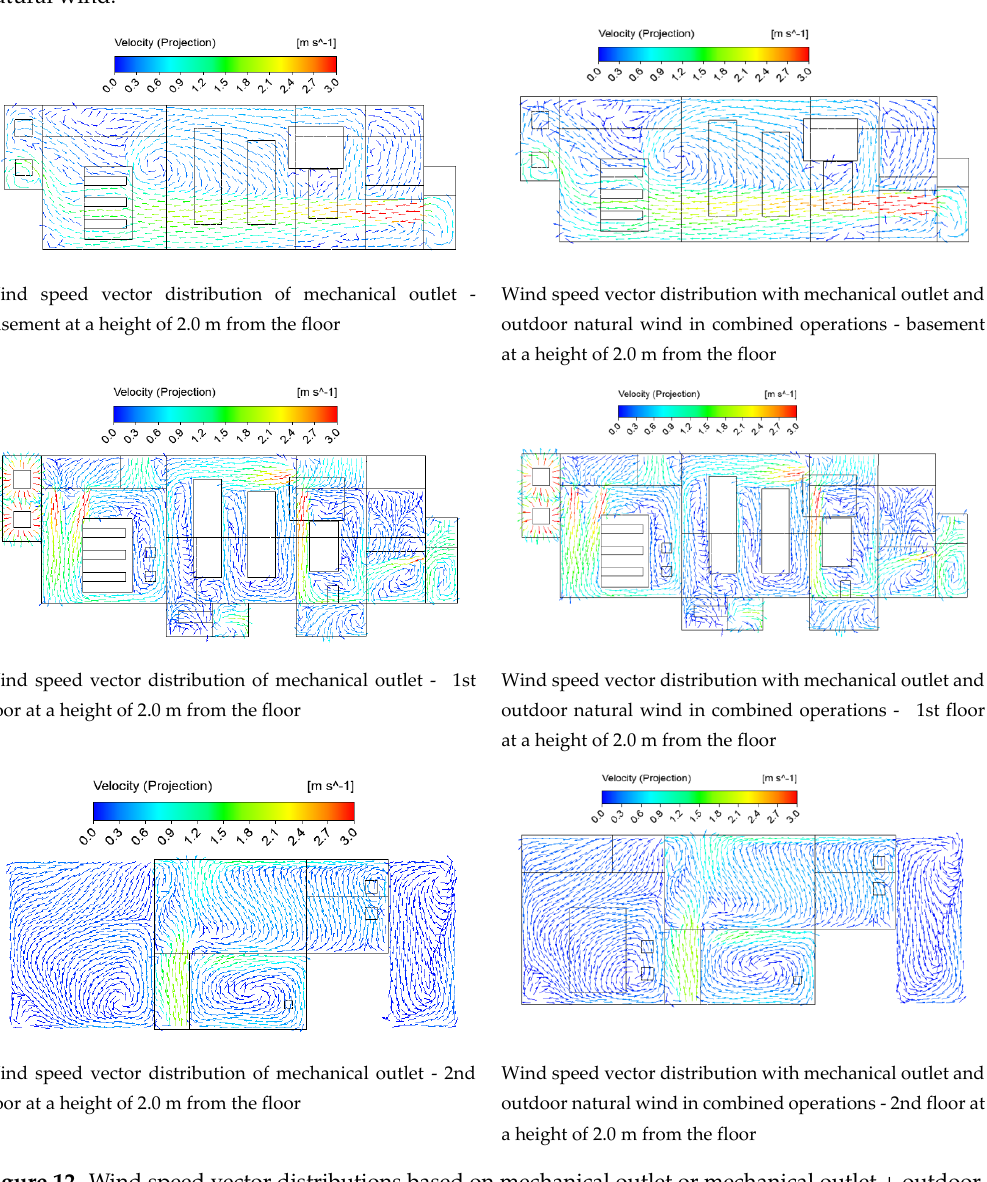
Figure 11. Wind speed gradient distributions based on mechanical outlet or mechanical outlet + outdoor natural wind.